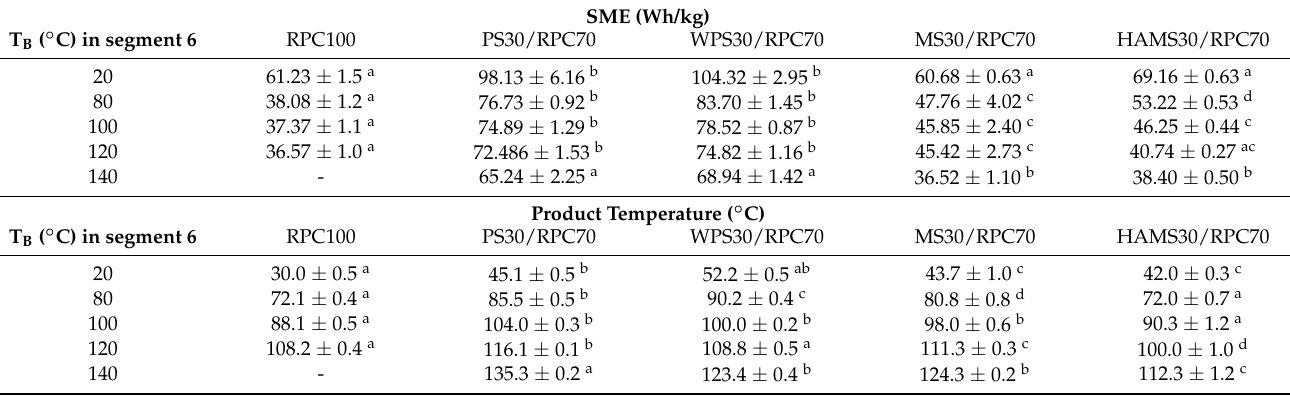
Table 3. Specific mechanical energy (SME) input and product temperature of extruded rapeseed press cake (RPC100) and blends of 30 g/100 g potato starch (PS), waxy potato starch (WPS), maize starch (MS) or high-amylose maize starch (HAMS) in combination with 70 g/100 g RPC as a function of barrel temperature T B